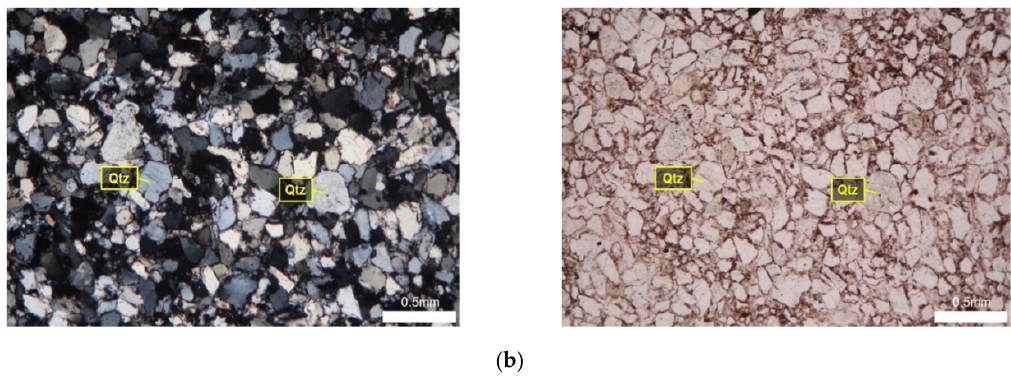
Figure 2. Petrographic images of the sample rocks from ( a ) Location A and ( b ) Location B (Qtz = quartz, Do = Dolomite, and Cal = Calcite; left-hand images = crossed polars, right-hand images = parallel polars).